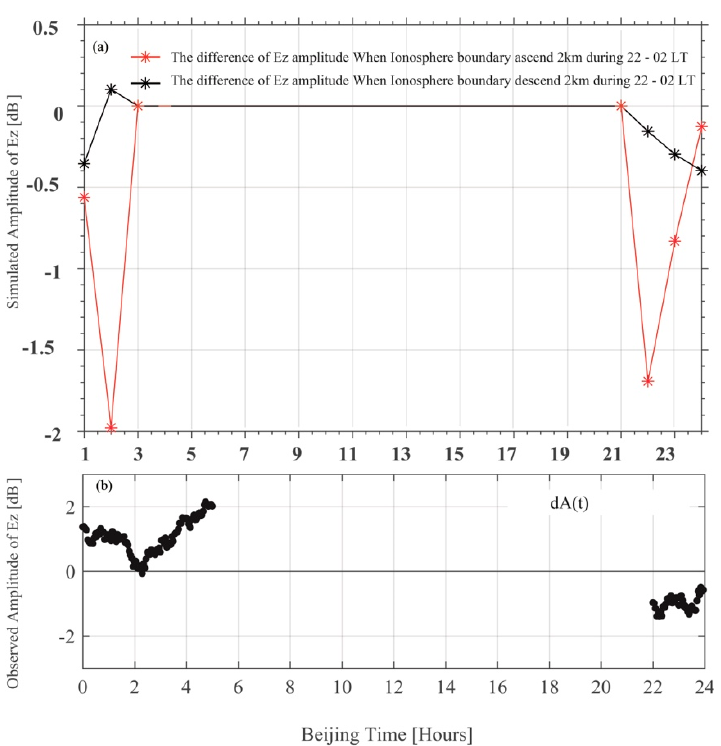
Figure 11. ( a ) The red solid line with asterisks represents the difference in Ez amplitude when the bottom height of the ionosphere is 82 and 80 km, the black solid line with asterisks represents the difference in Ez amplitude when the bottom height of the ionosphere is 78 and 80 km. ( b ) shows the difference in Ez components between 7 April (A(t)) and the running mean(<A(t)>). The black circles mark the selected nighttime data.